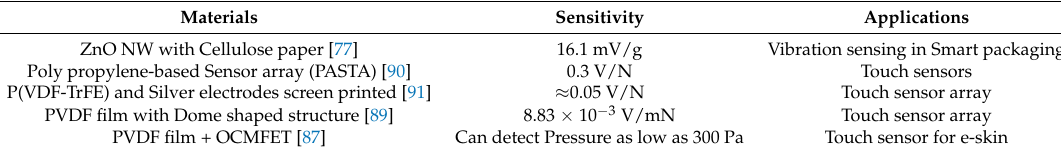
Table 5. Observations of recent developments in Tactile Sensors